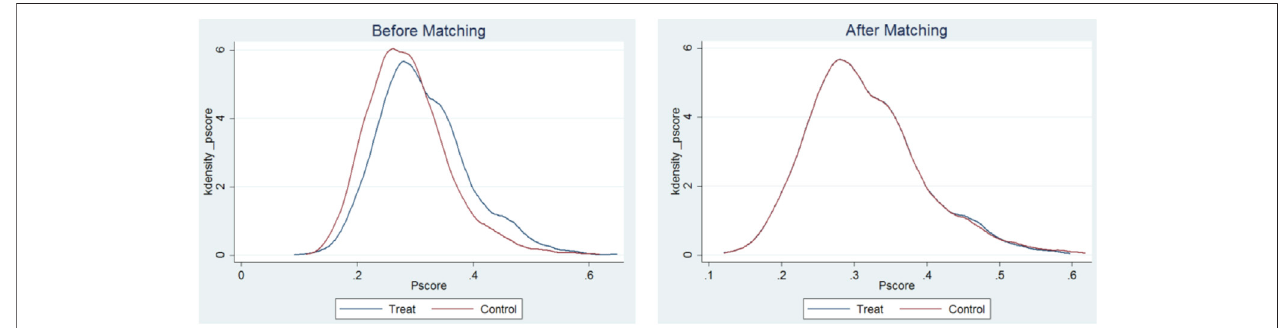
FIGURE 2 | Density score function diagram before and after matching (two column image).